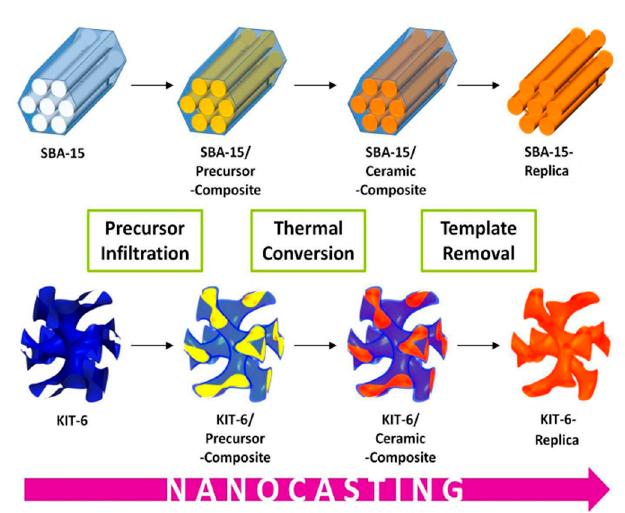
Figure 1. Scheme of the nanocasting synthesis route for ordered mesoporous non-silica materials. Adapted from [29]. Reprinted with permission from The Royal Society of Chemistry.